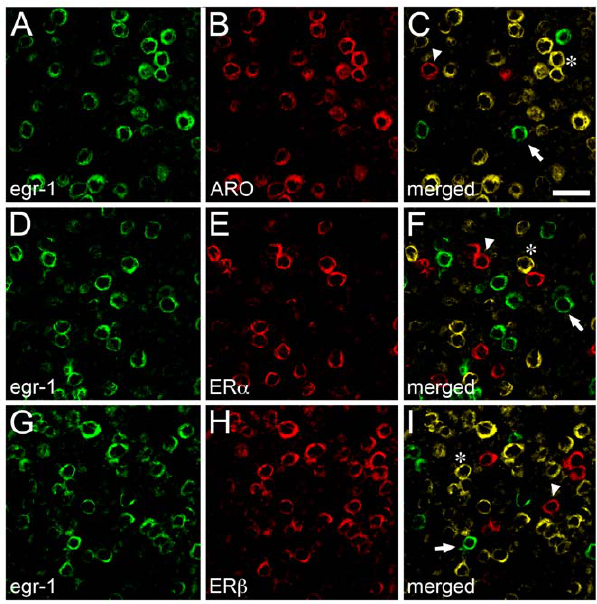
Figure 3. Visual experience activates estrogen-associated networks in V1. Photomicrographs illustrating the pattern of double-fluorescence in-situ hybridization (dFISH) signal in the V1 of mice stimulated for 30 min with ambient light, following overnight dark-adaptation (see Methods). Shown are representative fields depicting neurons that co-express the activity-dependent immediate early gene egr-1 (A, D and G) and ARO (B), ER a (E) or ER b (H) mRNAs. Merged images are shown in the right-most panels (C, F and I). Representative neurons that are positive only for egr-1 (arrows), or exclusively for ARO, ER a or ER b (arrowheads) can be readily identified in the images, along with examples of double-labeled neurons (asterisks). All images were obtained within a single optical slice using confocal microscopy. Scale bar=25 m m.